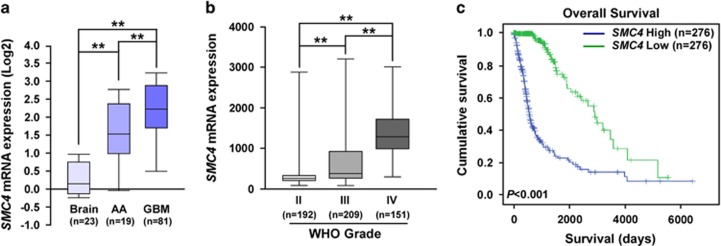
High SMC4 mRNA expression in human glioma correlates with poor prognosis. (a) Quantification analysis of SMC4 mRNA expression in normal brain tissues, anaplastic astrocytoma (AA), and GBM specimens from the Oncomine database (GSE4290 specimens). (b) Quantification analysis of SMC4 mRNA expression in 522 glioma specimens of different WHO grades from TCGA. (c) Correlation analysis of SMC4 mRNA expression and overall survival of 522 patients with glioma from TCGA. **P<0.01.